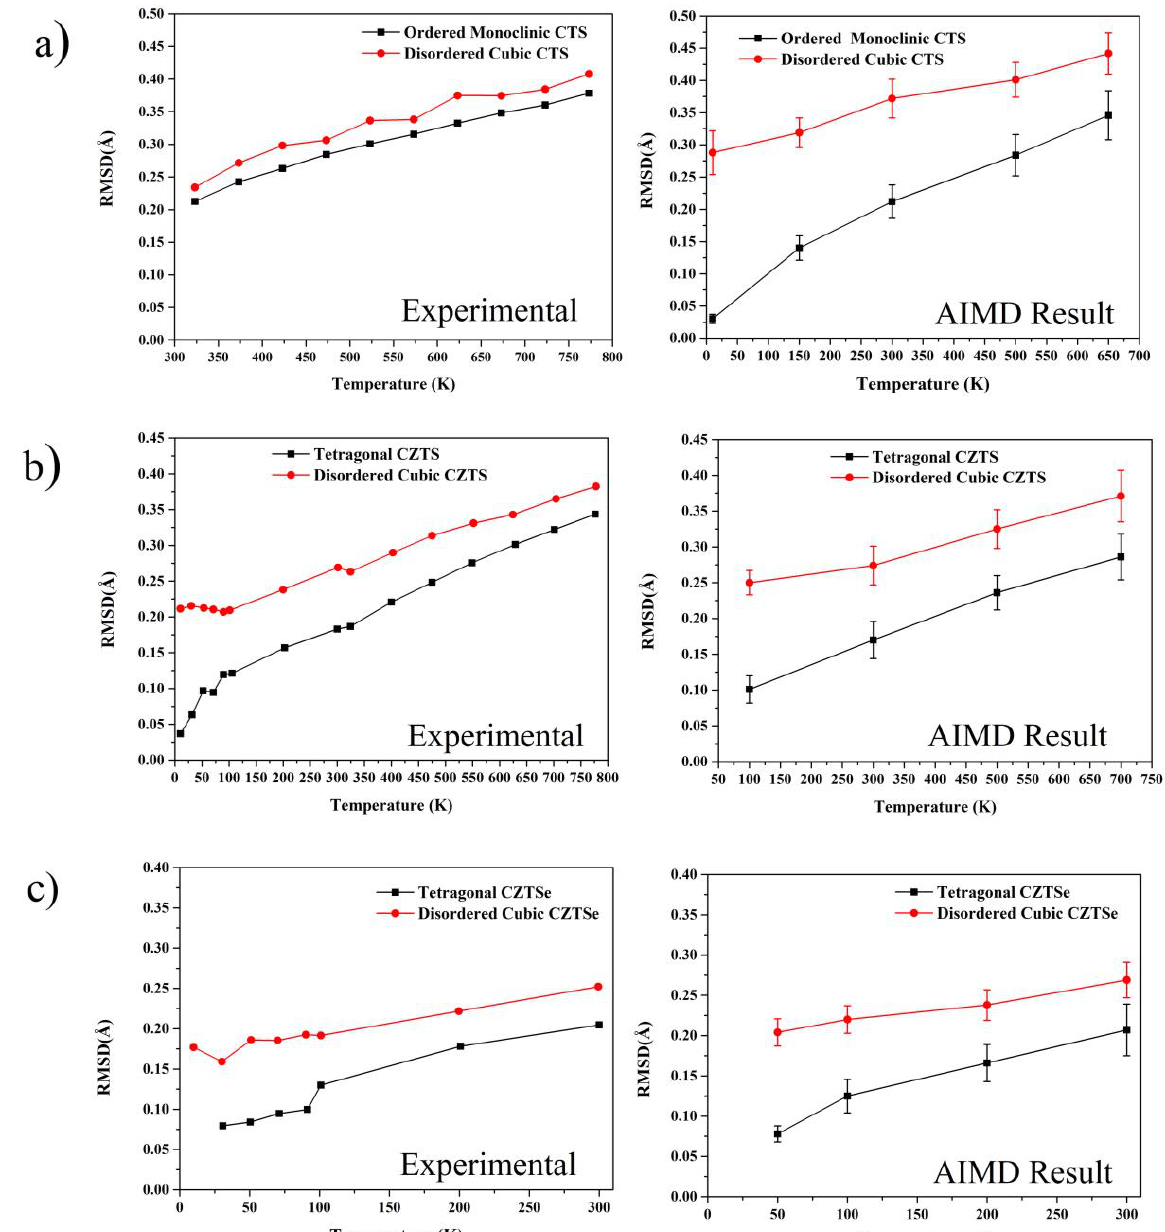
Figure 2. Temperature variation of RMSD calculated from SXRD and AIMD simulation for CTS ( a ), CZTS ( b ), and CZTSe ( c ).